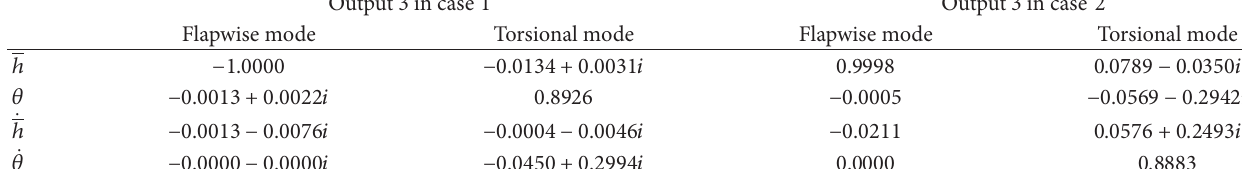
Table 4: Eigenvectors of the feedback system with output 3 for case 1 and case 2.